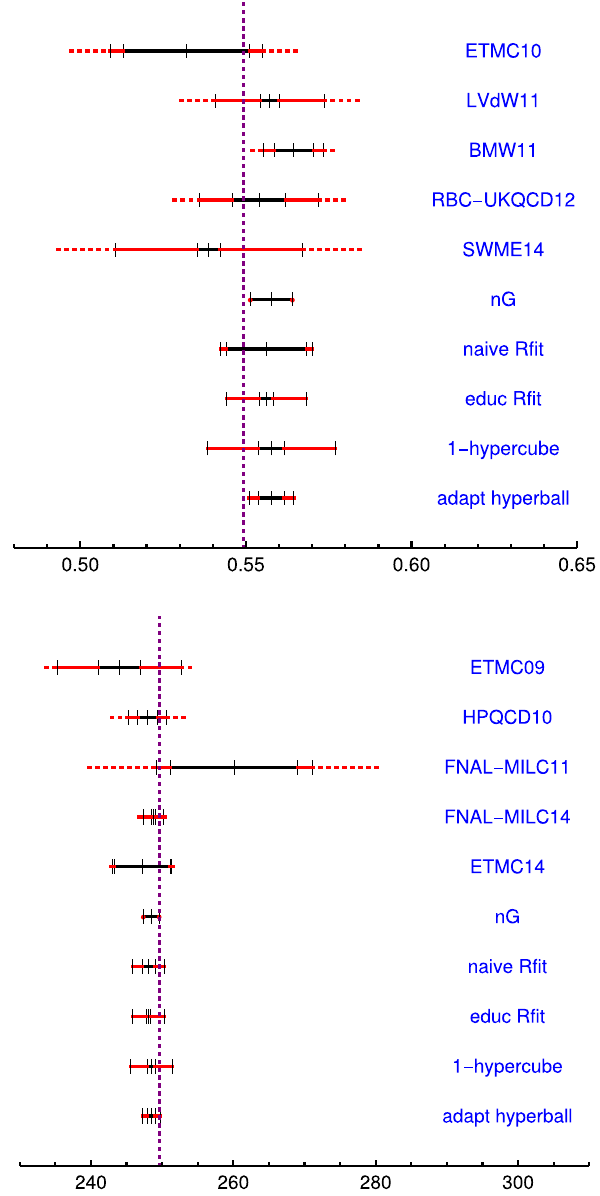
¯ MS ( 2GeV ) and the averages resulting from the Fig. 7 Top inputs for B K different models considered here. Bottom same for the lattice determi- nations of the D s -meson decay constant (in MeV). The black range gives the statistical error. For each individual input, the solid red range indicates the 1 σ interval according to the adaptive hyperball approach (combiningtheoreticalerrorsinquadratically)andthe dashedredrange according to the 1-fixed hypercube approach (combining theoretical errors linearly). For average according to the different approaches, the black range corresponds again to the statistical error, whereas the red range corresponds to the 1 σ interval following the corresponding approach. The comparison between black and red ranges illustrates the relativeimportanceofstatisticalandtheoreticalerrors.Finally,forillus- trative purposes, the vertical purple line gives the arithmetic average of the inputs (same weight for all central